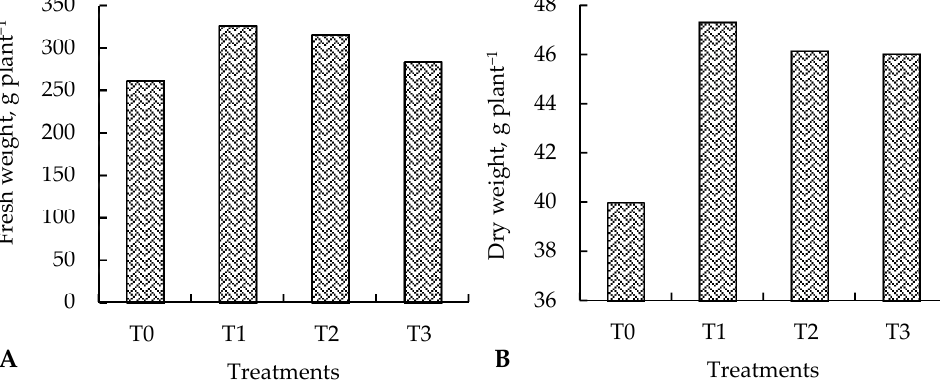
Figure 1. Fresh ( A ) and dry ( B ) weights of the plants.